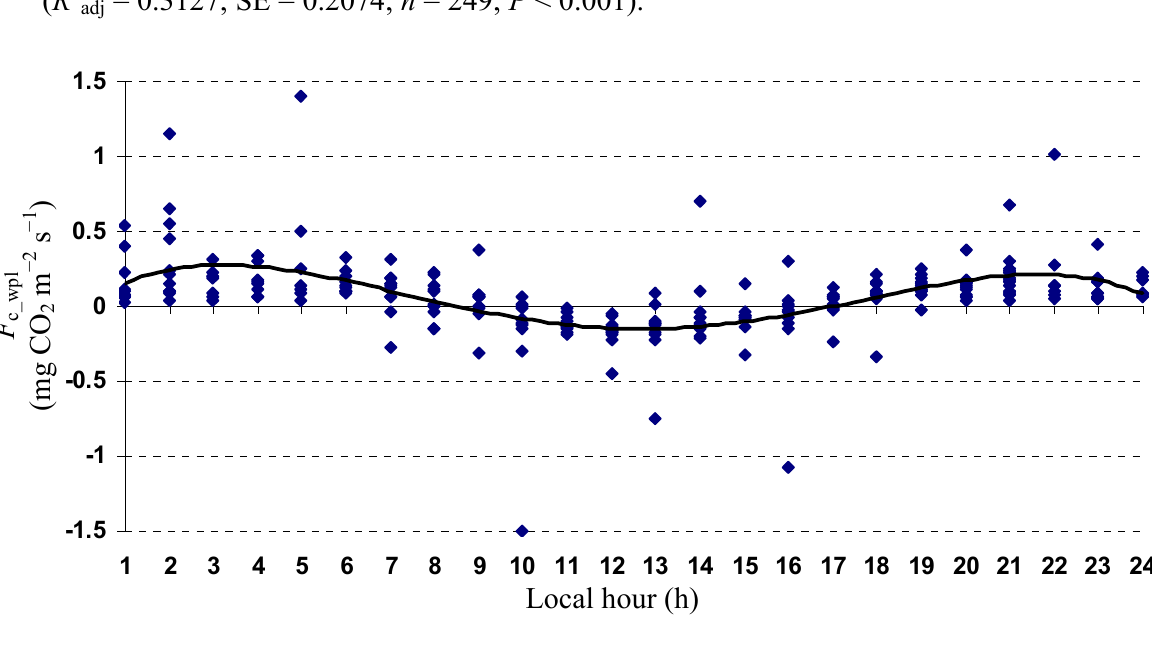
dataset for Yenicaga peatland in October Figure 7. A quartic function fitted to F c_wpl of 2010: F (mg CO m − 2 s − 1 ) = 0.1951 h − 0. 0423 h 2 ± 0.0027 h 3 − 5 × 10 − 5 h 4 c_wpl 2